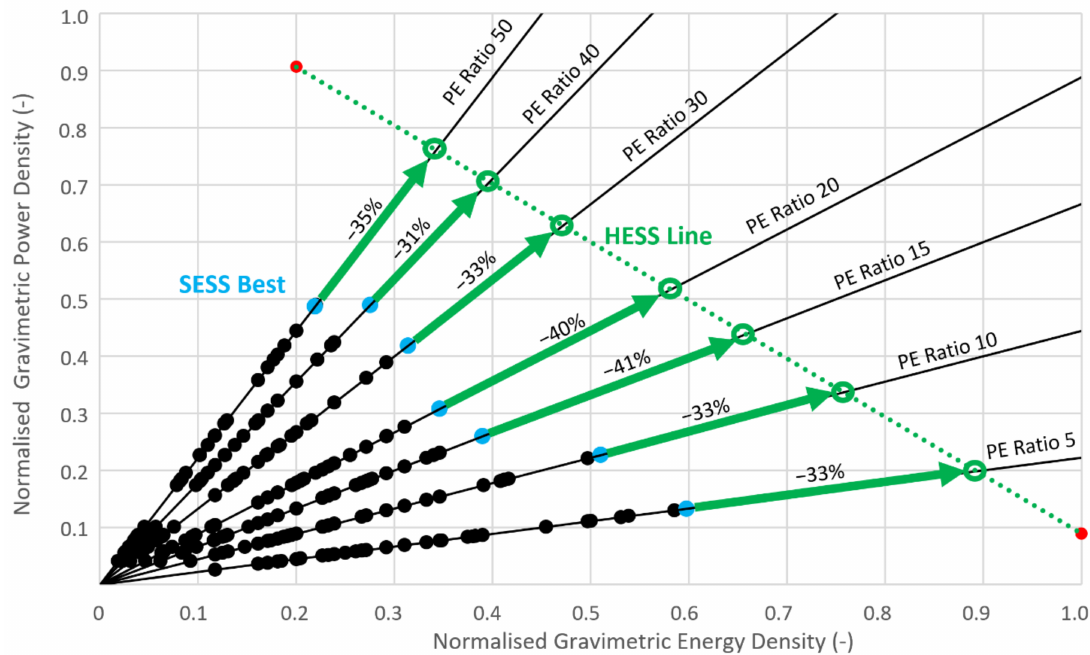
Figure 9. Ragone plot analysis method for evaluating the actual Pareto-front-based mass saving when using a hybrid energy storage system compared to a single energy storage system for different application PE ratios based on the currently available battery technology